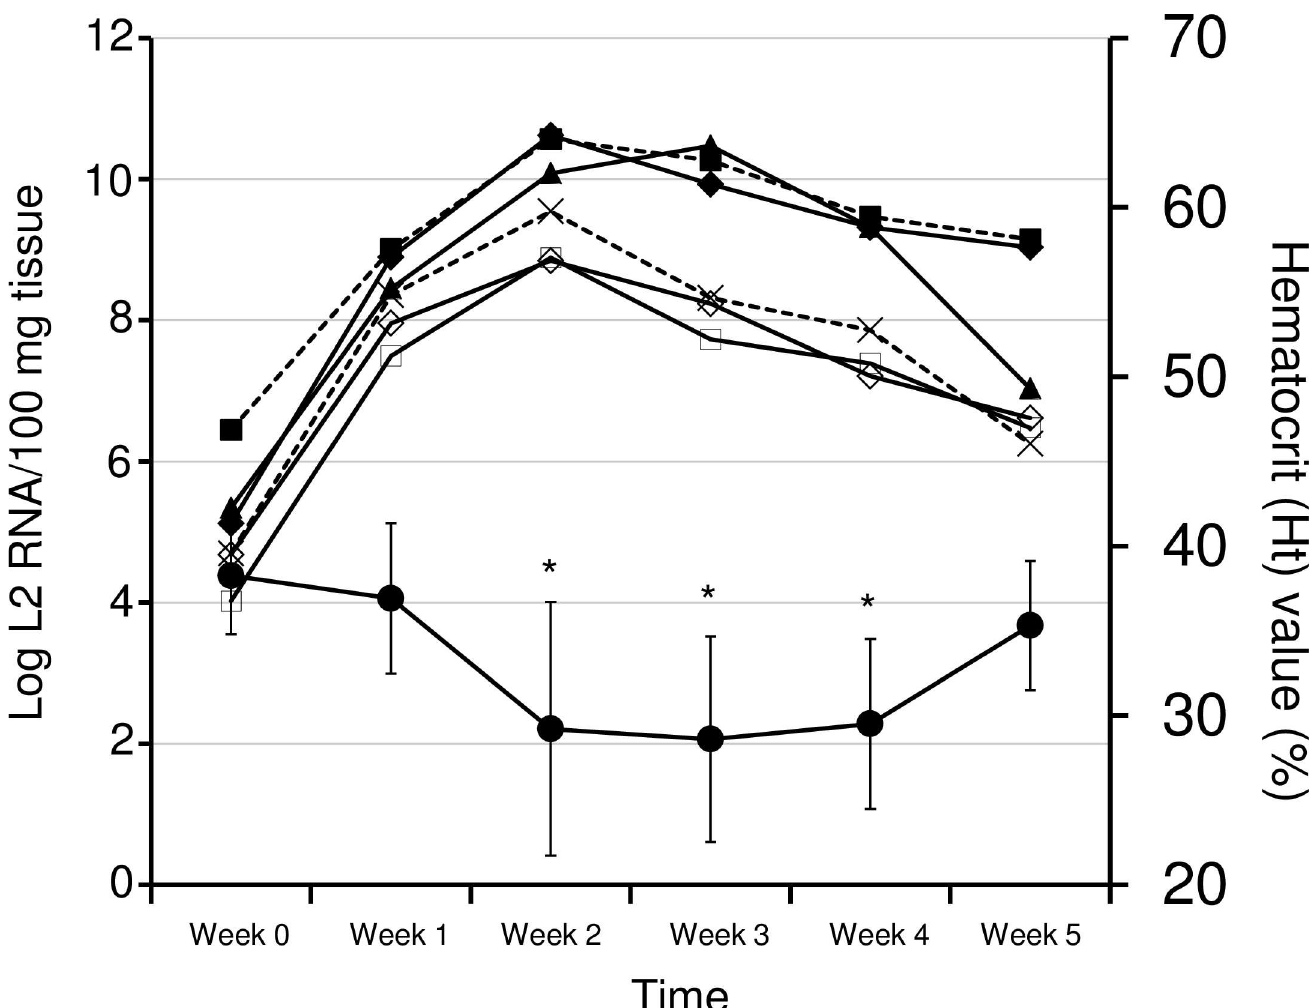
Fig 4. Time-course kinetics of the viral RNA loads in different tissues and the degrees of anemia during an EIBS epizoosis. Mean (n = 5) copy numbers of L2 RNA and hematocrit (Ht) values are shown in the graph. Heart ( ▲ ), intestine ( (cid:5) ), kidney ( ◆ ), liver ( × with broken line), muscle ( ◻ ), and spleen ( ■ with broken line) were tested for viral RNA loads. Viral loads are shown as the copy number of L2 RNA per 100 mg of tissue. Ht values are shown with closed circles ( ● ). Error bars for the Ht values represent standard deviations. ANOVA with the Tukey–Kramer method was used to confirm significant changes in the Ht values ( p < 0.05). Asterisks indicate significantly reduced Ht